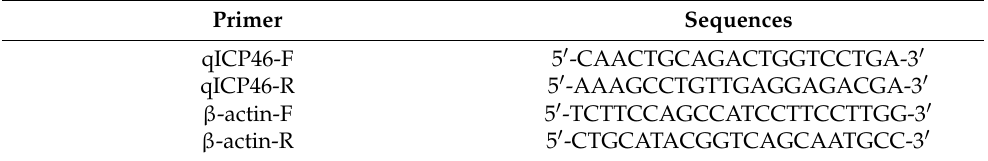
Table 1. Primers used for detecting (LMBV) infection by RT-qPCR. Primer